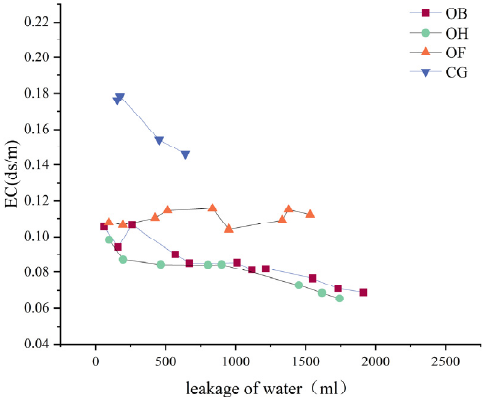
Figure 4. Variation of leachate EC with the amount of leaching water.